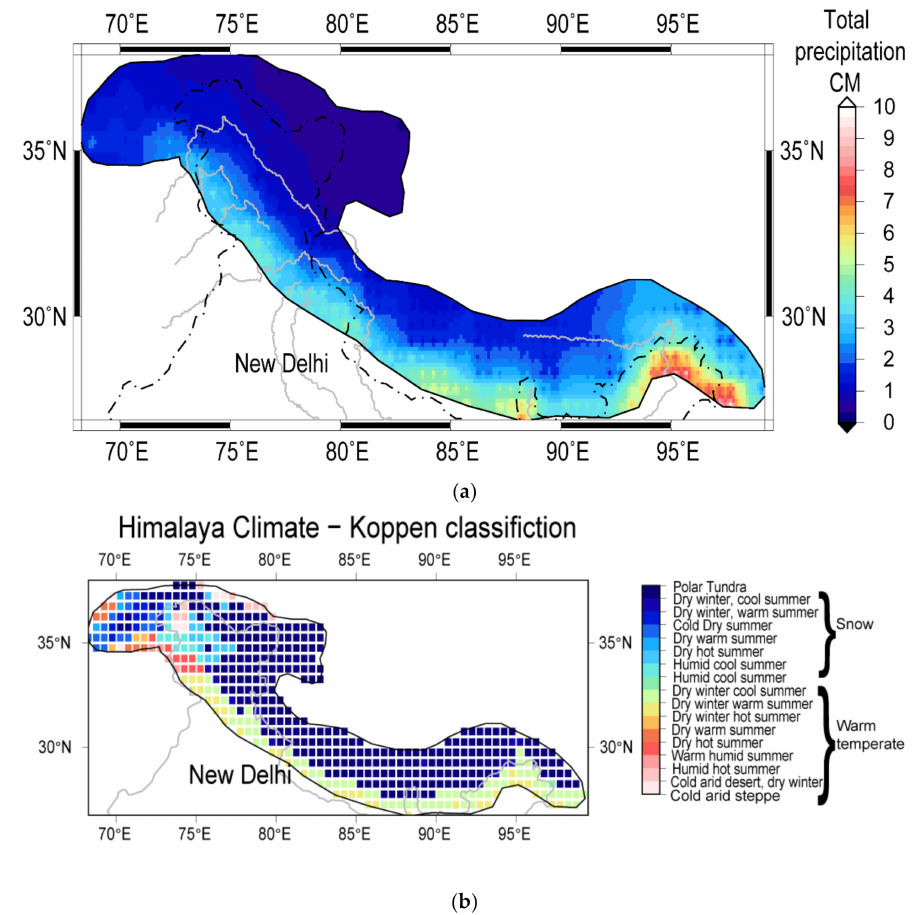
Figure 1. ( a ) Mean total precipitation for the period 2002–2017 ( b ) Köppen Climate classification from Kottek and others, 2006. Index for letters in the code: P = Polar, T = Tundra, D = Dry, w = winter, W = Warm, H = humid, h = hot, s = summer, c = cool, C = cold a = arid, d = desert, S =